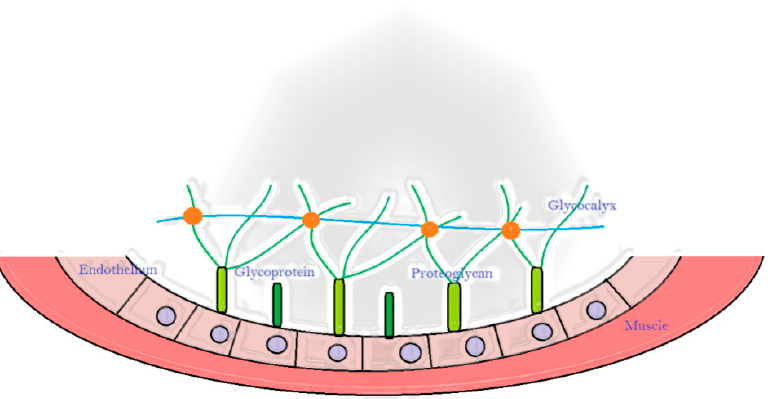
Figure 8. Vascular endothelium is physically sustained by glycocalyx, a carbohydrate-rich layer to which is connected with proteoglycans and glycoproteins in the internal side of the vessels.